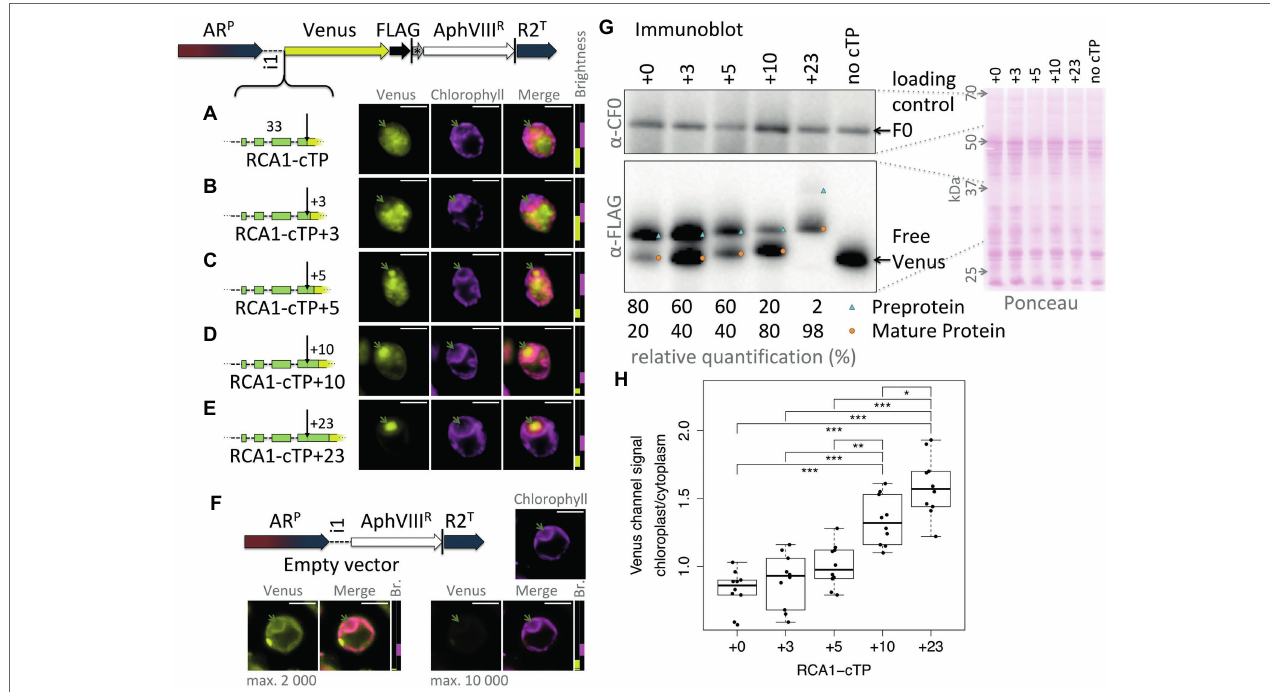
FIGURE 1 | RCA1-cTP relies on residues past the cleavage site to support efficient chloroplast import. (A–E) Constructs were generated by inserting candidate peptides upstream of Venus in a bicistronic expression vector made of the following components: AR P : Hybrid HSP70A - RBCS2 promoter, i1: RBCS2 intron 1, Venus: Venus fluorescent protein (a YFP variant), FLAG: triple-FLAG tag, |: stop codon, *: bicistronic intergenic sequence (tagcat), AphVIII R : Paromomycin resistance gene, and R2 T : RBCS2 terminator. Here, candidate peptides are the Rubisco activase (RCA1) chloroplast targeting peptide (cTP), extended by (A) +0, (B) +3, (C) +5, (D) +10, or (E) +23 residues beyond the cleavage site into the mature protein. Lengths in amino acid residues are indicated above peptide cartoons. Introns within peptides are symbolized by dashed lines. Typical epifluorescence images of resulting transformants in strain T222 + show fluorescence from the Venus channel in yellow and chlorophyll autofluorescence in magenta. The position of the pyrenoid is highlighted by a green arrow in each image. All scale bars are 5 μ m in length. Image brightness (Br.) was adjusted for clarity by restricting the visualized intensities to a subset of recorded intensity values, as shown to the right of micrographs (intensity 0 at bottom, 65535 at the top; 2000 indicated by a black dotted line). (F) A control transformed with an empty vector shows the extent of autofluorescence in the Venus channel. (G) Whole-cell protein extracts were normalized to 5 μ g chlorophyll per lane. Ponceau-red staining of the membrane used for blotting gives an indication of equal loading and the quality of the transfer. The mitochondrial ATPsynthase subunit F0, immunolabeled with an antibody raised against chloroplast ATPsynthase subunit CF0, is shown as a loading control. FLAG was immunolabeled to visualize the migration of the Venus reporter in each strain. Preprotein (labeled with a blue triangle) migrates above mature protein that had the cTP cleaved upon chloroplast import (labeled with an orange circle). A relative quantification was done on a less exposed image; a slightly overexposed image was chosen as visual representation to show the presence of preprotein in the RCA1-cTP + 23 strain. (H) Epifluorescence images were quantified by measuring mean Venus channel signal inside and outside the chloroplast. Statistical significance is indicated as: * p < 0.05, ** p < 0.01, and *** p < 0.001;Tukey’s honestly significant difference post-hoc test, after